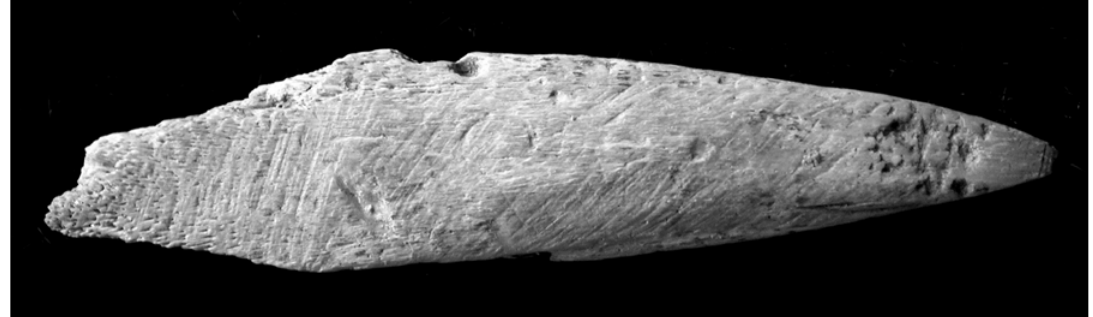
Fig. 2 . Photograph of rostral tooth (43 mm) utilized by hunter-gatherers of Tenório Site. (Photo: Wagner Silva). The tooth was abraded on its medial edge, modeling the tip base and the lateral edge was slightly in order to file the tip.